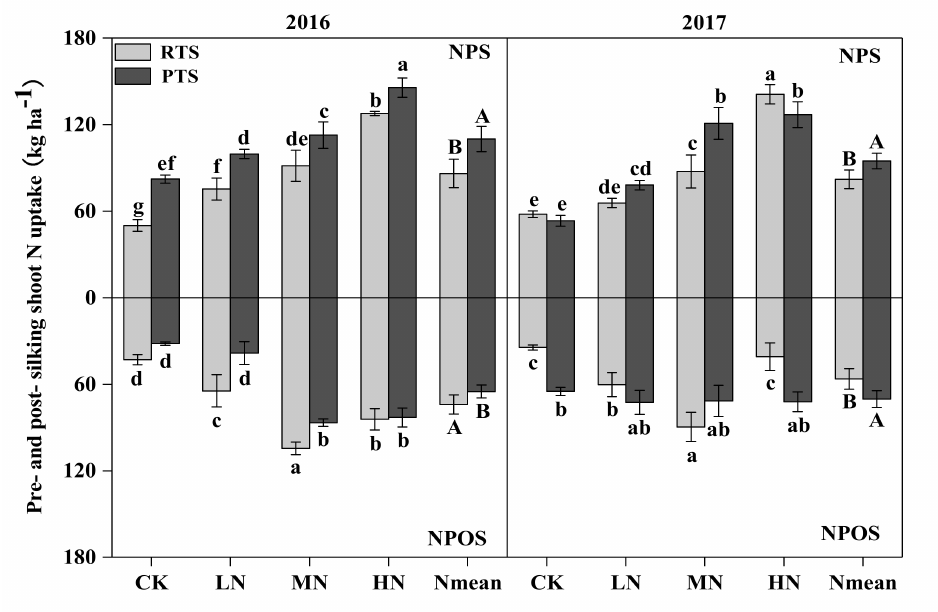
Figure 6. Response of shoot N uptake at maize pre-silking and post-silking to tillage with straw incorporation and N level management in 2016–2017. NPS, shoot N uptake at pre-silking of maize; NPOS, shoot N uptake post-silking of maize; RTS, rotary tillage with straw incorporation; PTS, plow tillage with straw incorporation. CK, LN, MN, and HN indicate 0, 112, 187, and 262 kg N ha − 1 applied, respectively. Nmean, the mean values of di ff erent N. Di ff erent uppercase and lowercase letters indicate significant di ff erences for shoot N uptake before and after maize silking between tillage with straw incorporation and N treatment for p < 0.05 level,